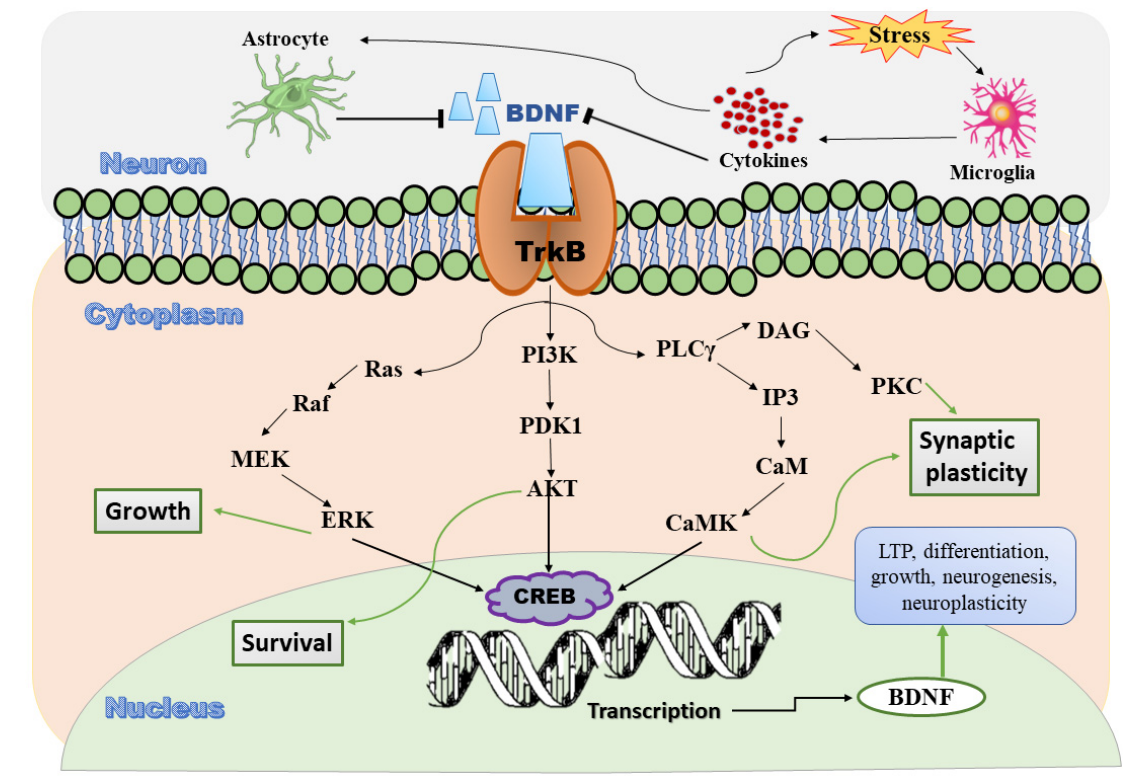
Figure 1. Diagrammatic presentation of signaling pathway of BDNF metabolism. BDNF binds to its high-affinity receptor tyrosine kinase B (TrkB) through the activation of intracellular tyrosine kinase, resulting in the autophosphorylation of TrkB receptors and the sequential activation of three independent cascades. BDNF signaling pathways stimulate one or more transcription factors (cAMP response element binding protein (CREB) and CREB-binding protein) in the nucleus that regulate the expression of genes encoding proteins involved in neural plasticity, differentiation, growth, survival, and stress resistance. The sharp arrow indicates activation, and the T-shaped arrow indicates inhibition. BDNF, brain-derived neurotrophic factor; TrkB, tropomyosin receptor kinase B; PI3K, induction via phosphatidylinositol 3-kinase; PLC γ , phospholipase C γ ; Akt, serine/threonine protein kinase; CaM, calmodulin; CaMK, calcium/calmodulin-dependent protein kinase; CREB, cAMP response element binding protein; DAG, diacylglycerol; ERK, extracellular signal-regulated kinase; IP3, inositol 1,4,5-trisphosphate; MEK, mitogen-activated extracellular signal-regulated kinase; PKC, protein kinase C; PDK1, 3-phosphoinositide-dependent kinase 1.